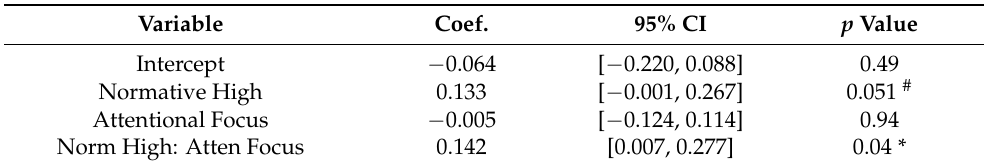
Table 4. Results for the model output from the backwards stepwise feature selection of durations of first looks in the pre-labeling period. Variable Coef. 95% CI p Value Intercept − 0.064 [ − 0.220, 0.088] 0.49 Normative High 0.133 [ − 0.001, 0.267] 0.051 # − 0.005 [ − 0.124,